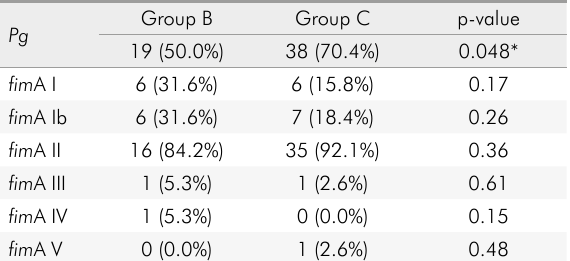
Table 3. Prevalence of P. gingivalis and fimA genotypes according to